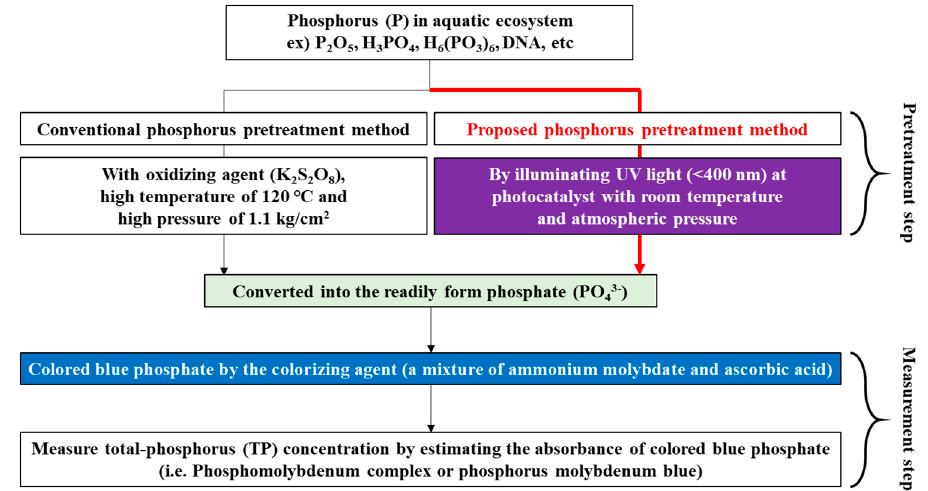
Figure 1. Principle of TP analysis utilizing the conventional and proposed methods.